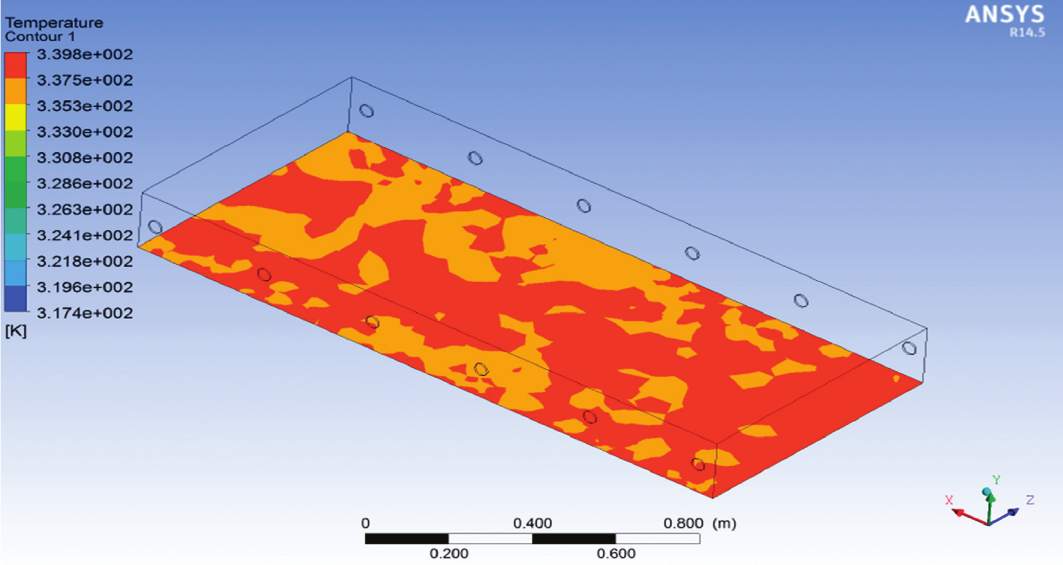
Figure 11: Effect of the temperature contour on the absorber plates.